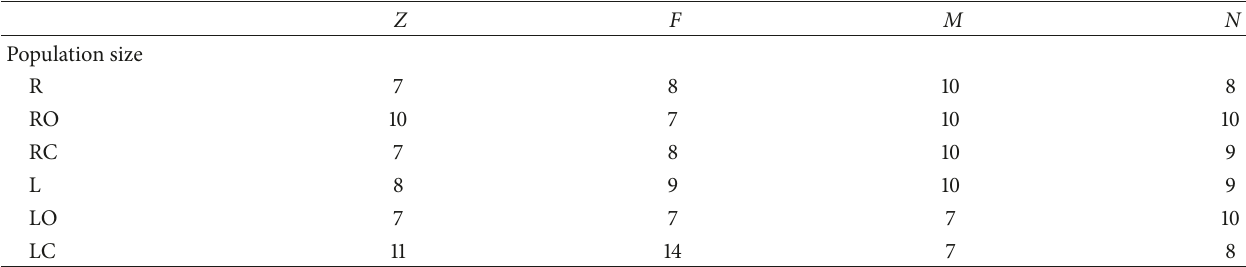
Table 1: Population size of agents